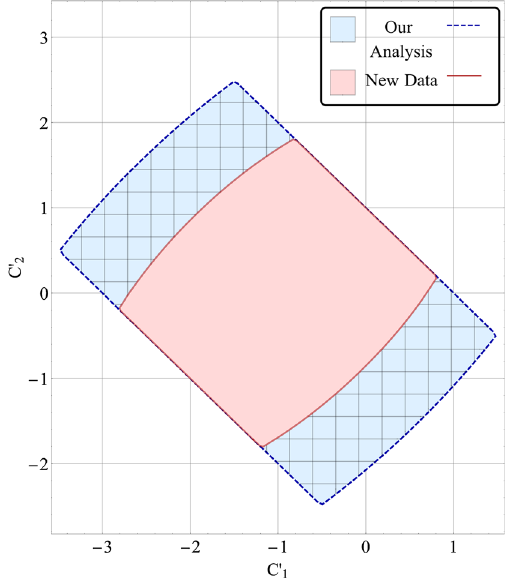
Fig. 1 Allowed ranges of C (cid:11) region allowed by the recent Belle data [2]